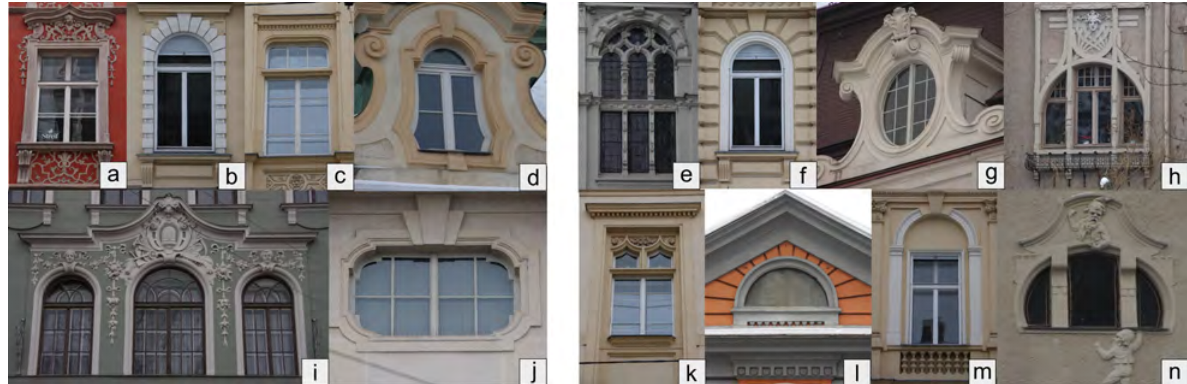
Figure 10: Windows that cannot be handled properly by our current system. The left group of windows could be handled by special- purpose assets, the right group reveals more fundamental issues and problems. See Section 6.1 for an explanation.